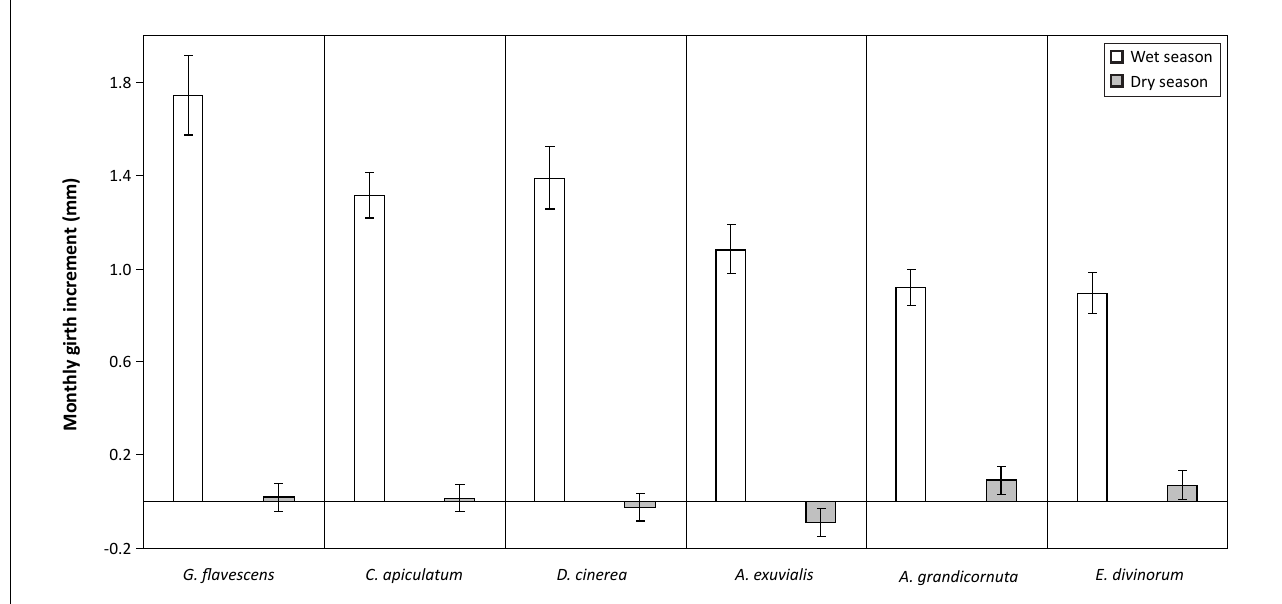
FIGURE 4: Mean monthly increment in stem girth of six abundant woody species in the wet and dry seasons across all treatments at the Nkuhlu exclusion experiment, 2006–2010. Species from left to right are: Grewia flavescens , Combretum apiculatum , Dichrostachys cinerea , Acacia grandicornuta , Acacia exuvialis and Euclea divinorum . Error bars are standard errors of the means ( n = 44 for G. flavescens , 39 for D. cinerea , 39 for C. apiculatum , 42 for A. exuvialis , 41 for A. grandicornuta , and 39 for E. divinorum ). in favour of thorns or spines (Kutsch et al . 2008; Scholes